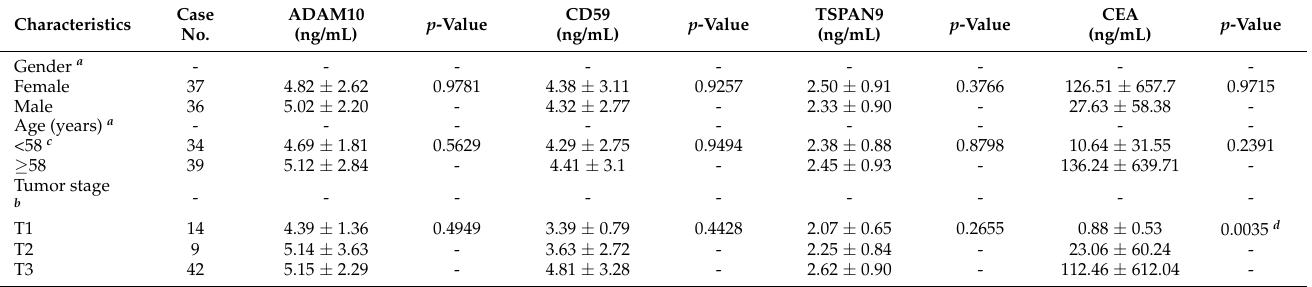
Table 3. Correlations of plasma EV ADAM10, CD59 and TSPAN9 levels with clinicopathological characteristics of CRC